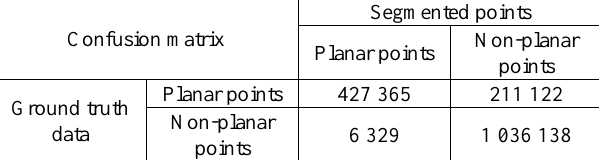
Table 4. Confusion matrix achieved by PCA